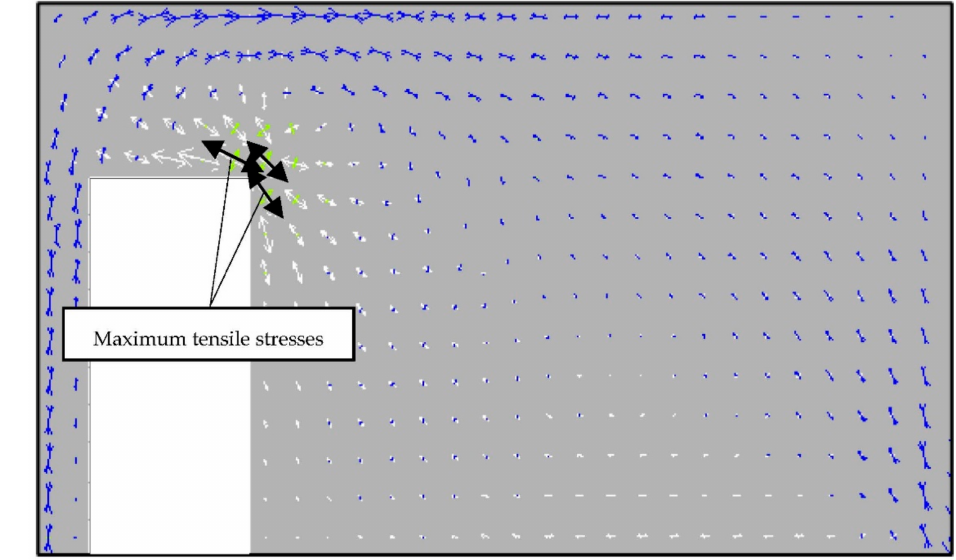
Figure 11. Trajectories of the main stresses in the wall with door opening moved to the vertical edge of the wall.